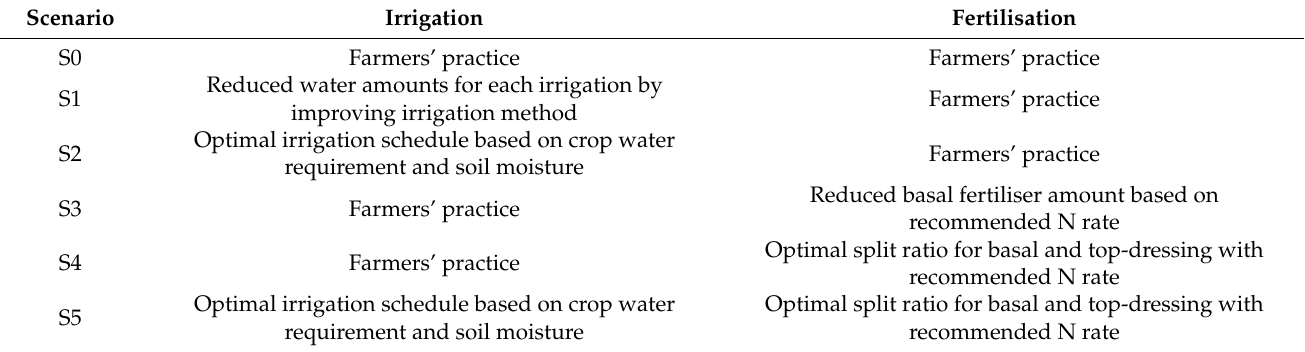
Table 2. Overview of developed